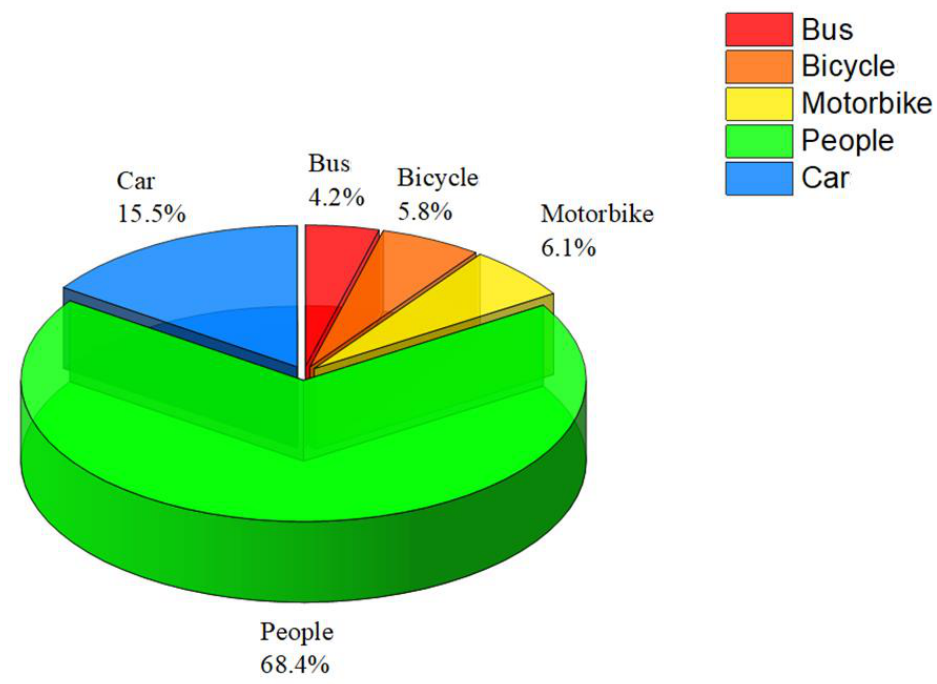
Figure 13. Percentage of ground truth for each target.